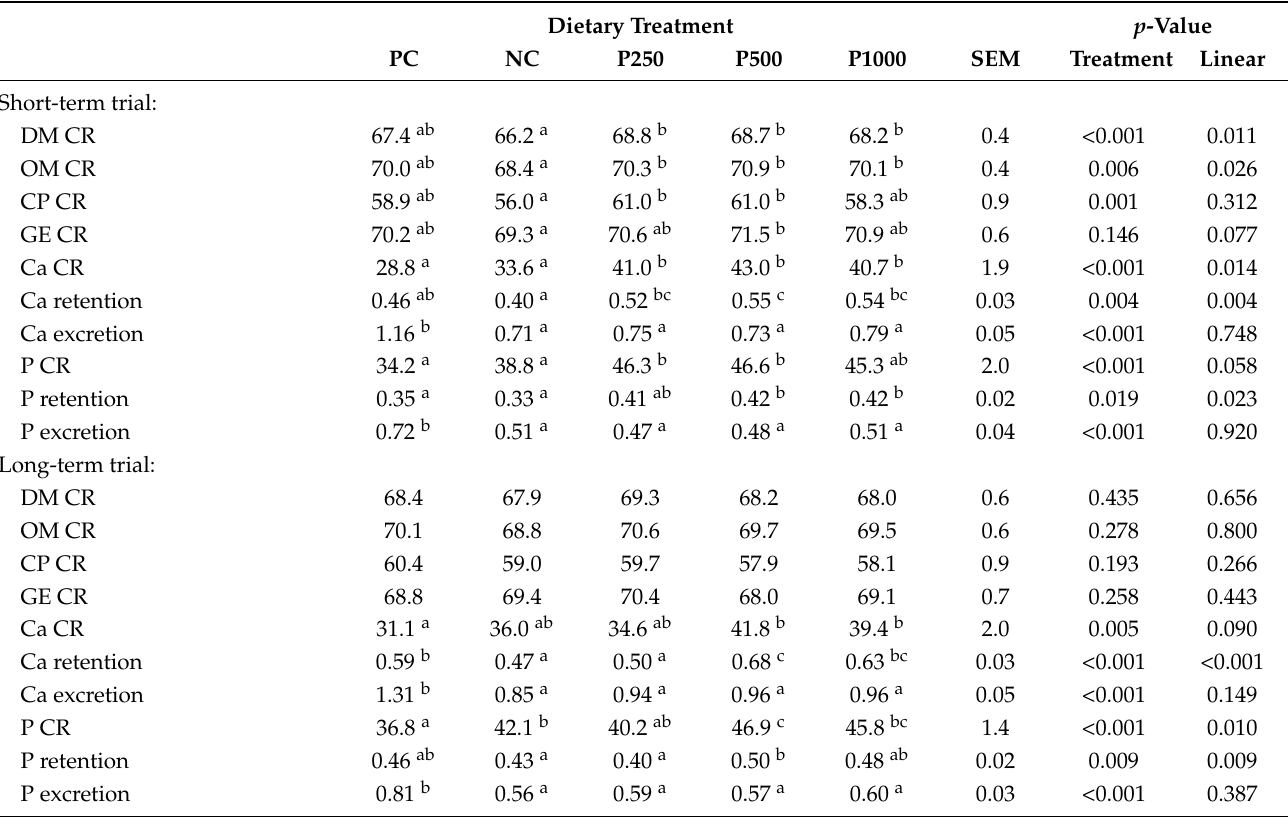
Table 4. Effect of mineral and phytase inclusion levels on nutrient coefficient of retention (CR, %), retention (g/d animal), and excretion (g/d animal) of broilers in both short- and long-term trials (35 to 38 days of